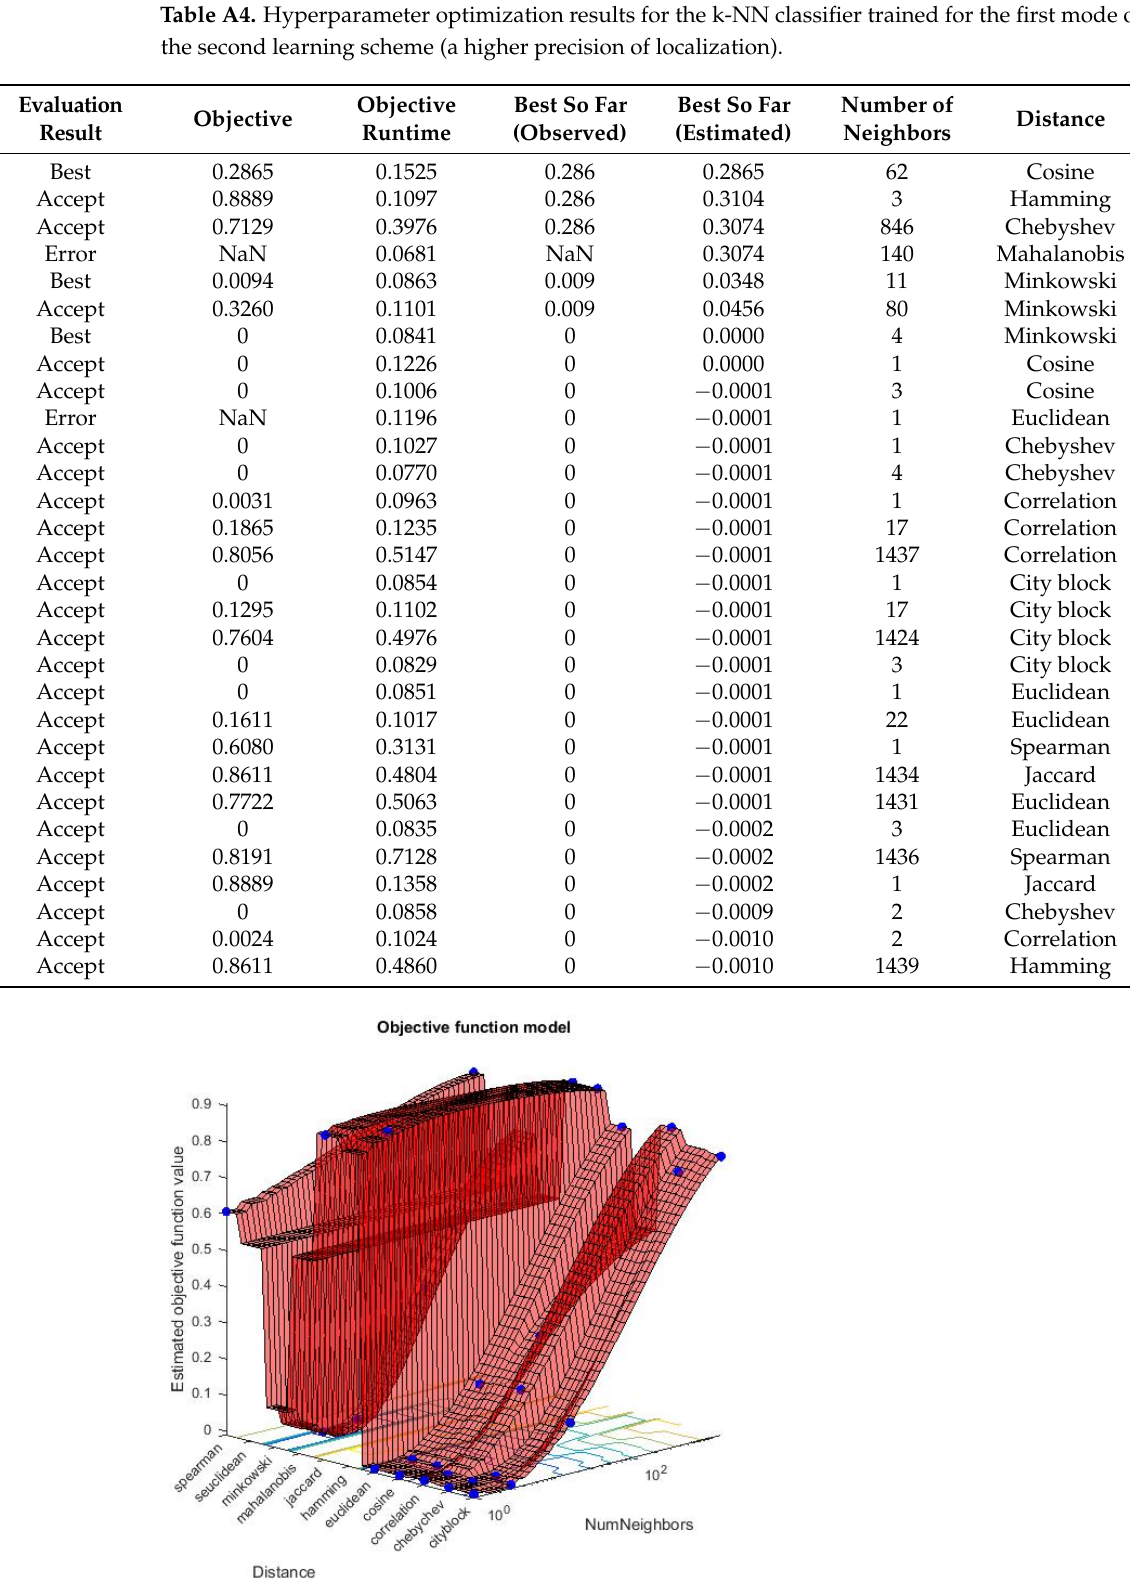
Figure A7. Objective function evaluation plot for the k-NN classifier trained for the first mode of the second learning scheme (higher precision of localization). References 1.